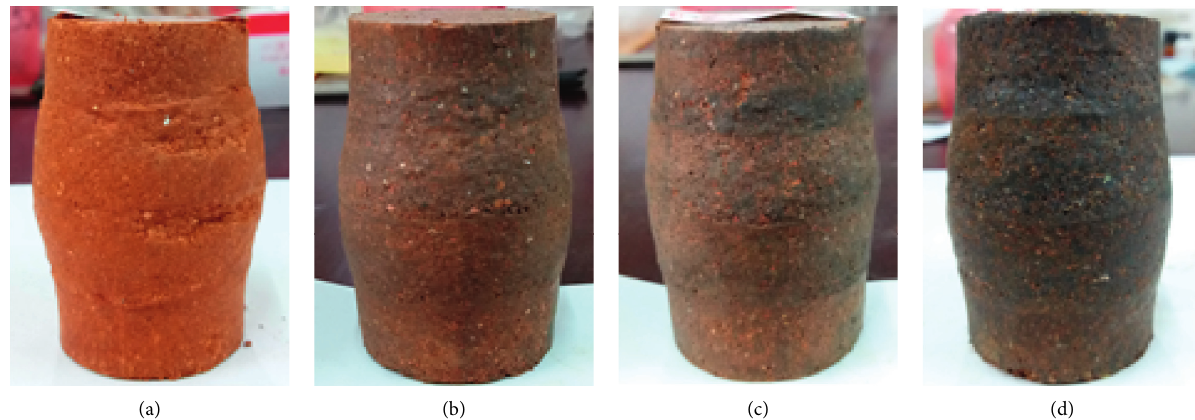
Figure 3: GN-laterite samples after triaxial test, (a) M � 0%, (b) M � 0.5%, (c) M � 1.0%, (d) M �